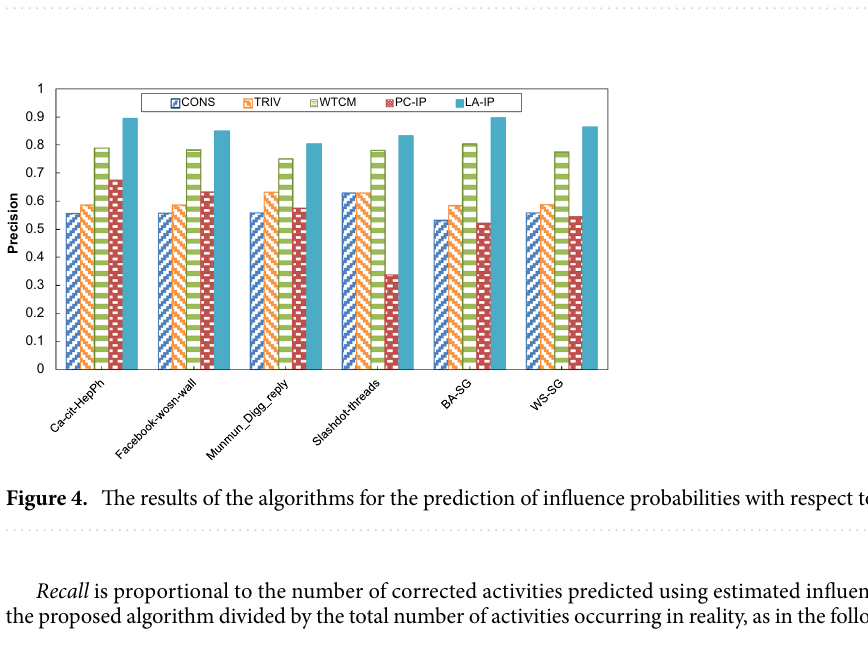
Figure 3. The results of the algorithms for prediction of influence probabilities with respect to F-measure.